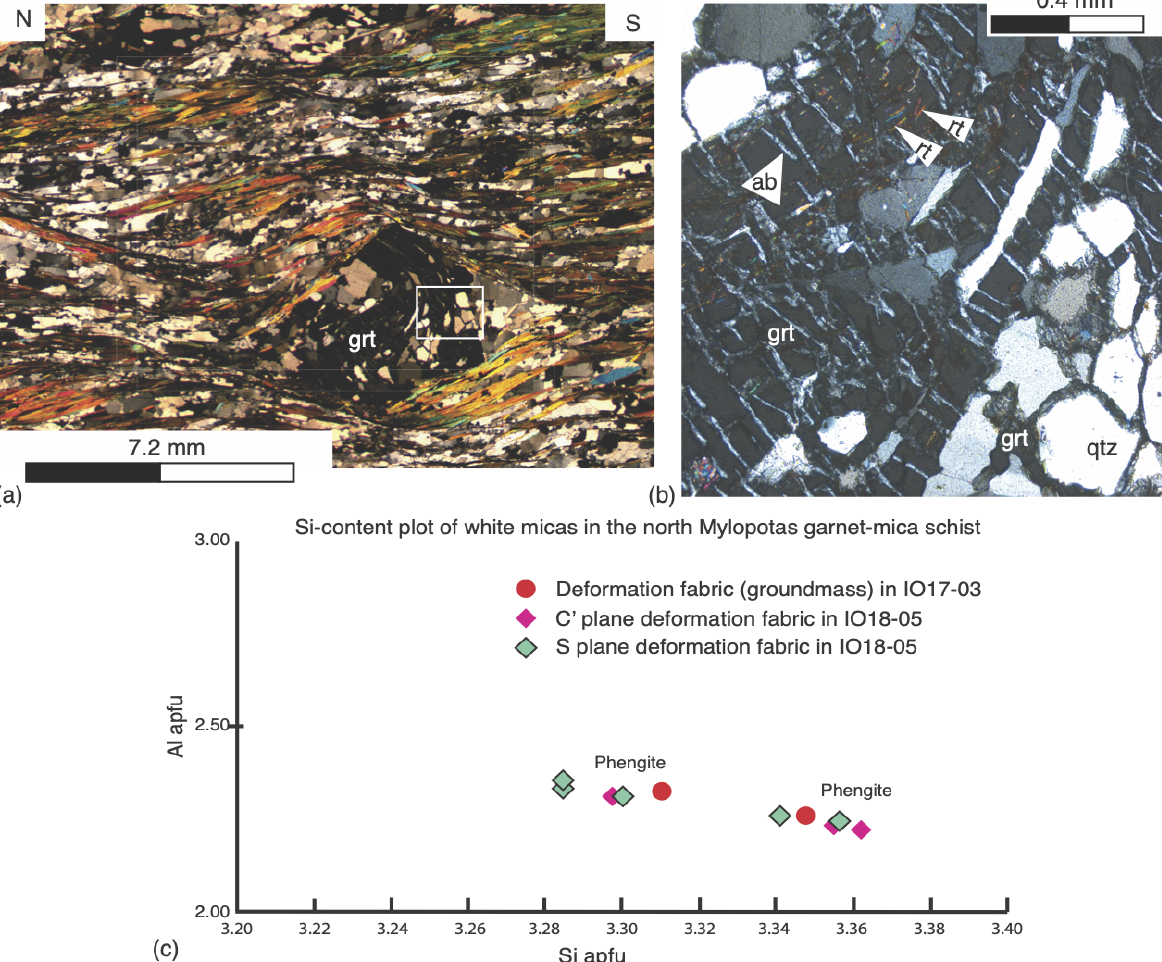
Figure 7. Sample IO18-05, garnet–mica schist collected in the fold hinge of the earliest fold (overprinted by the south-directed shear zone) in the mid-level garnet–mica schist tectonic slice. (a) A garnet porphyroblast preserving relicts of earlier deformation fabrics as inclusions and developed a skeletal structure once it reached the Al-depleted zone. (b) Rutile inclusions and albite exsolution trails observed in the garnet porphyroblast. (c) A Si-content plot indicating the presence of two phengite groups in the garnet–mica